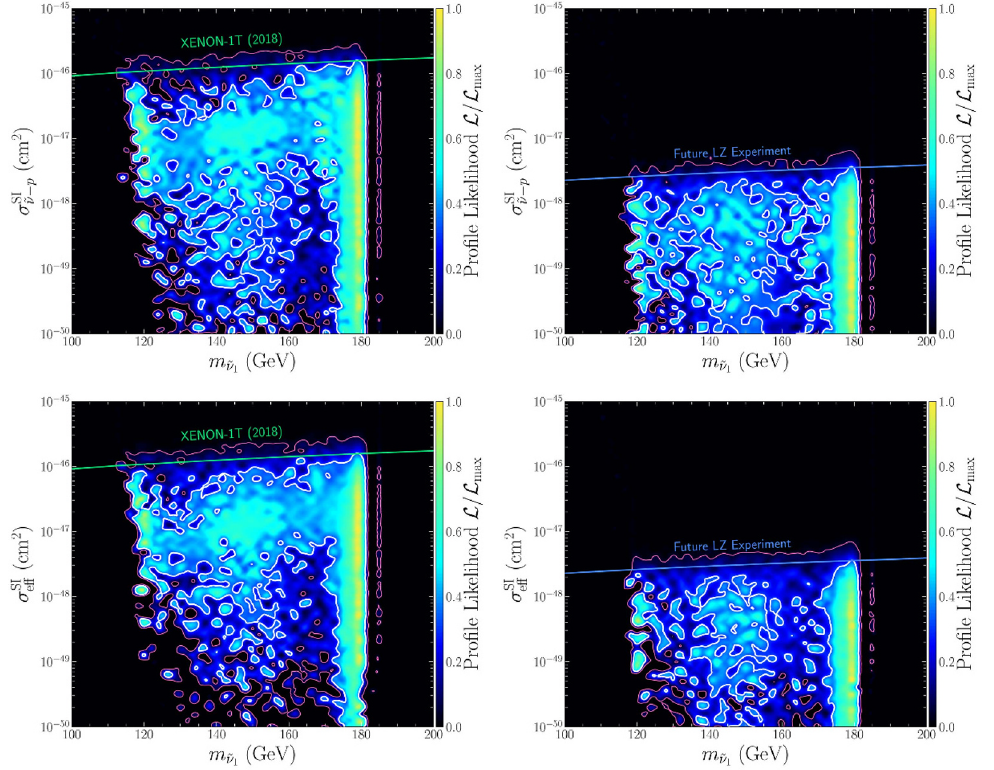
Figure 2 . Same as figure 1, but for the profile likelihood projected onto σ SI